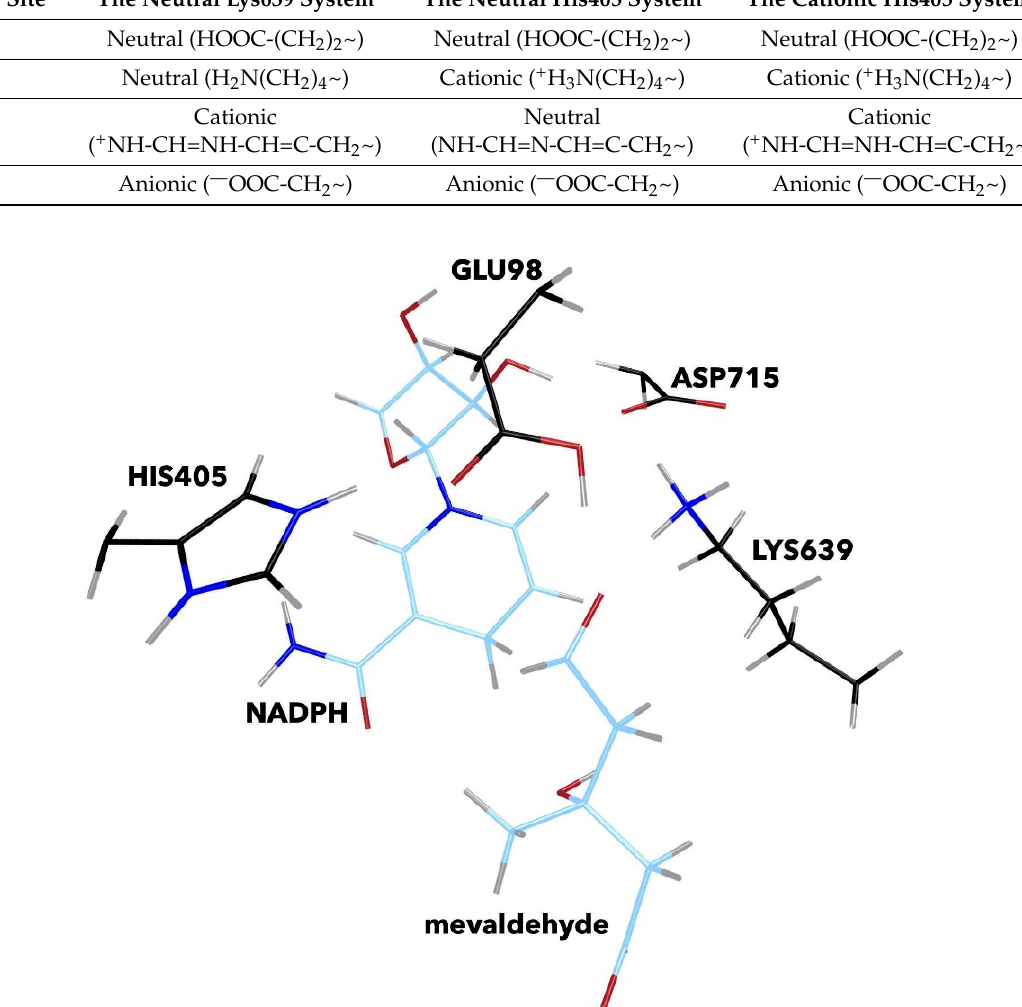
Table 1. Description of the differences among each modeled system. All systems included a mevaldehyde intermediate and NADPH. Residues in the Active Site